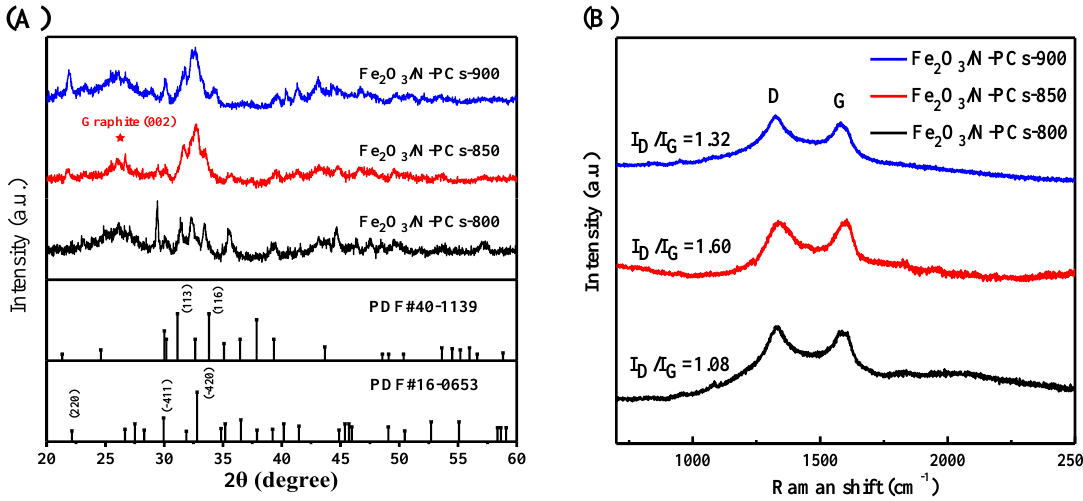
Figure 3. XRD pattern ( A ) and Raman spectra ( B ) of Fe 2 O 3 /N-PCs-800, Fe 2 O 3 /N-PCs-850 and Fe 2 O 3 /N-PCs-900.